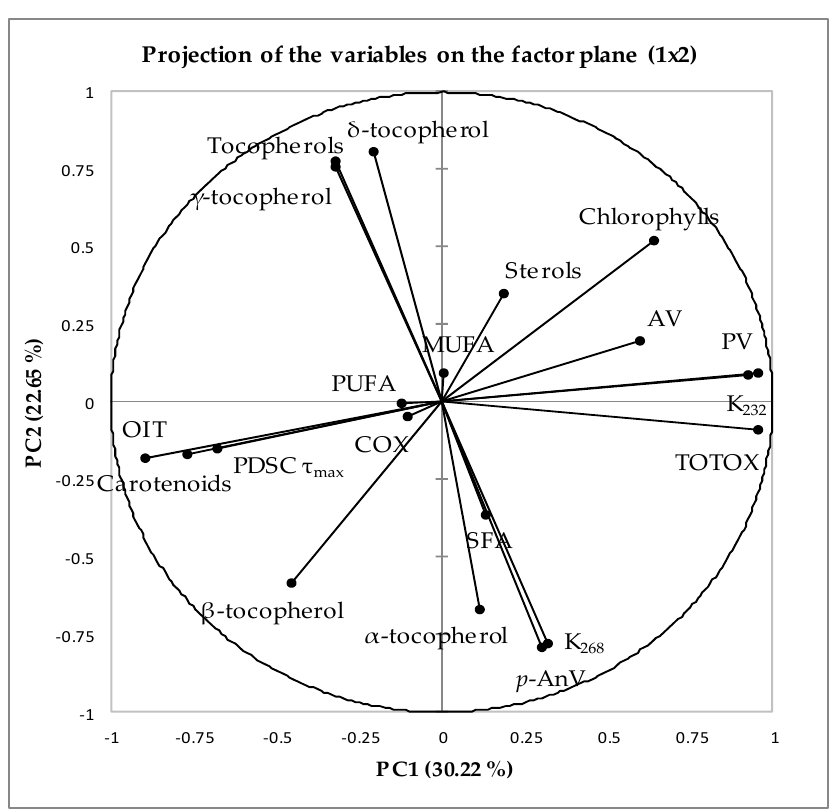
Figure 1. Principal component analysis (PCA) based on quality features of analyzed camelina oils.